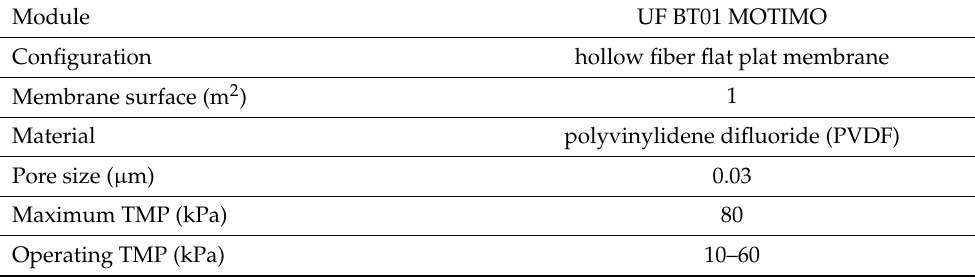
Table 3. UF Membrane characteristics of the MBR